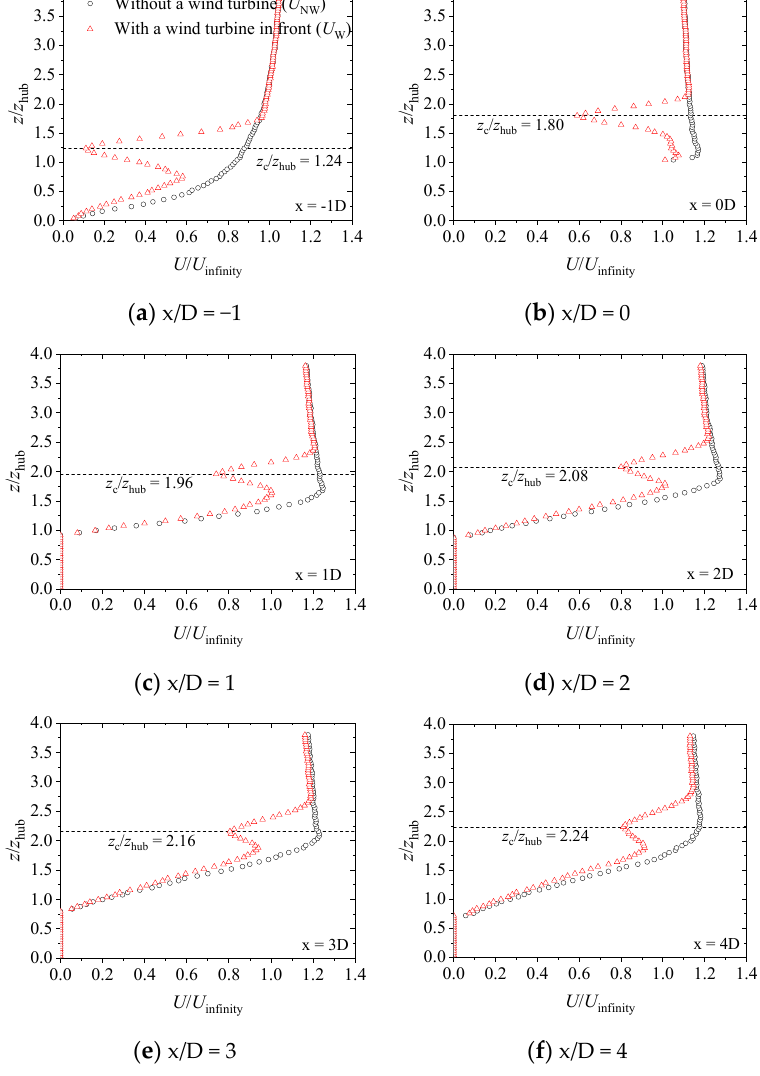
( h ) x/D = 6 Figure 11. A detailed comparison of the wake with the wind turbine located 2D in front (case 3, x/D = − 1 to 6).